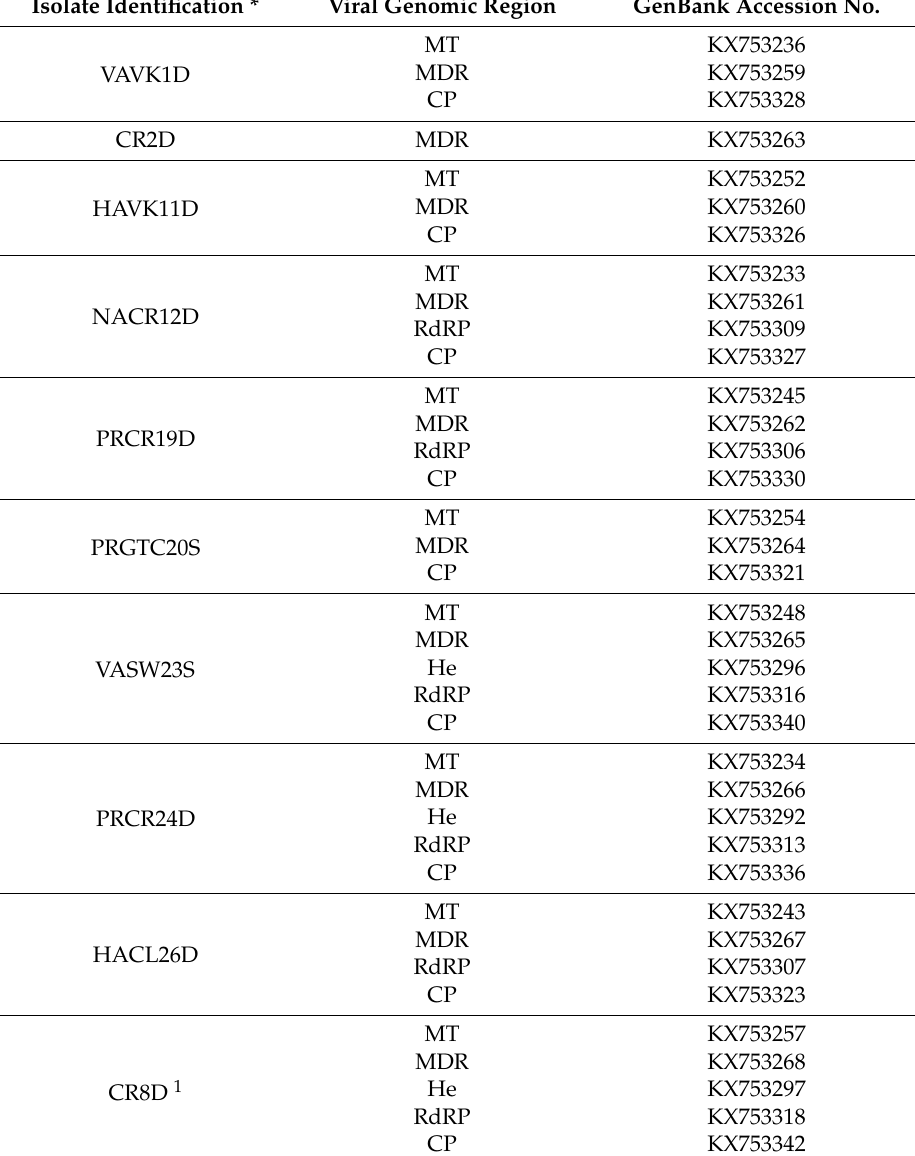
Table 3. List of CSDaV sequences obtained in this work. Accession numbers in the GenBank database for the different genomic regions of each isolates are